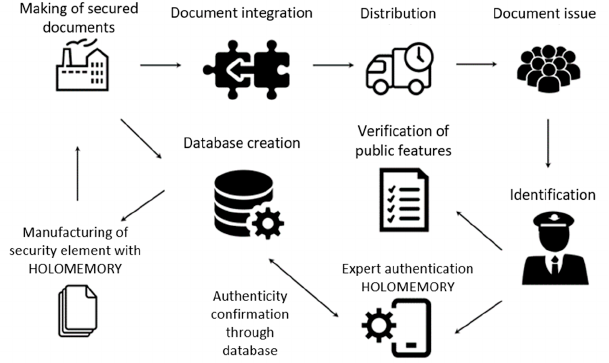
12 of 14 Figure 15. Example of an individualized micro-CGH.